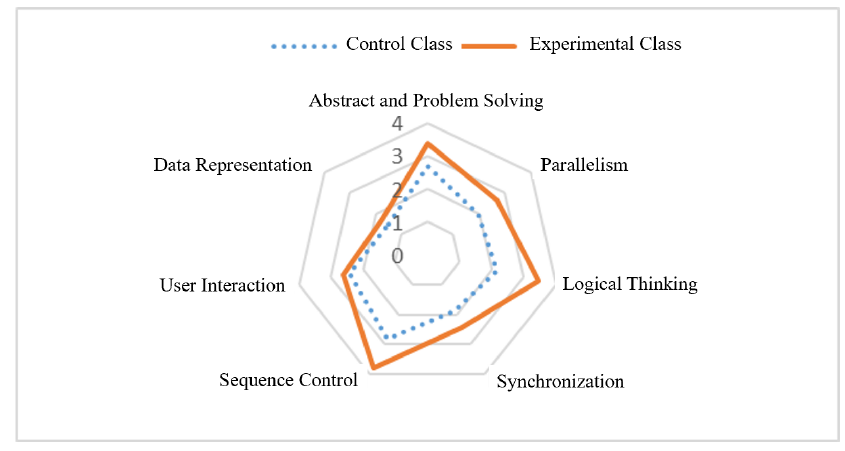
Figure 5. The results of post-test data on CT